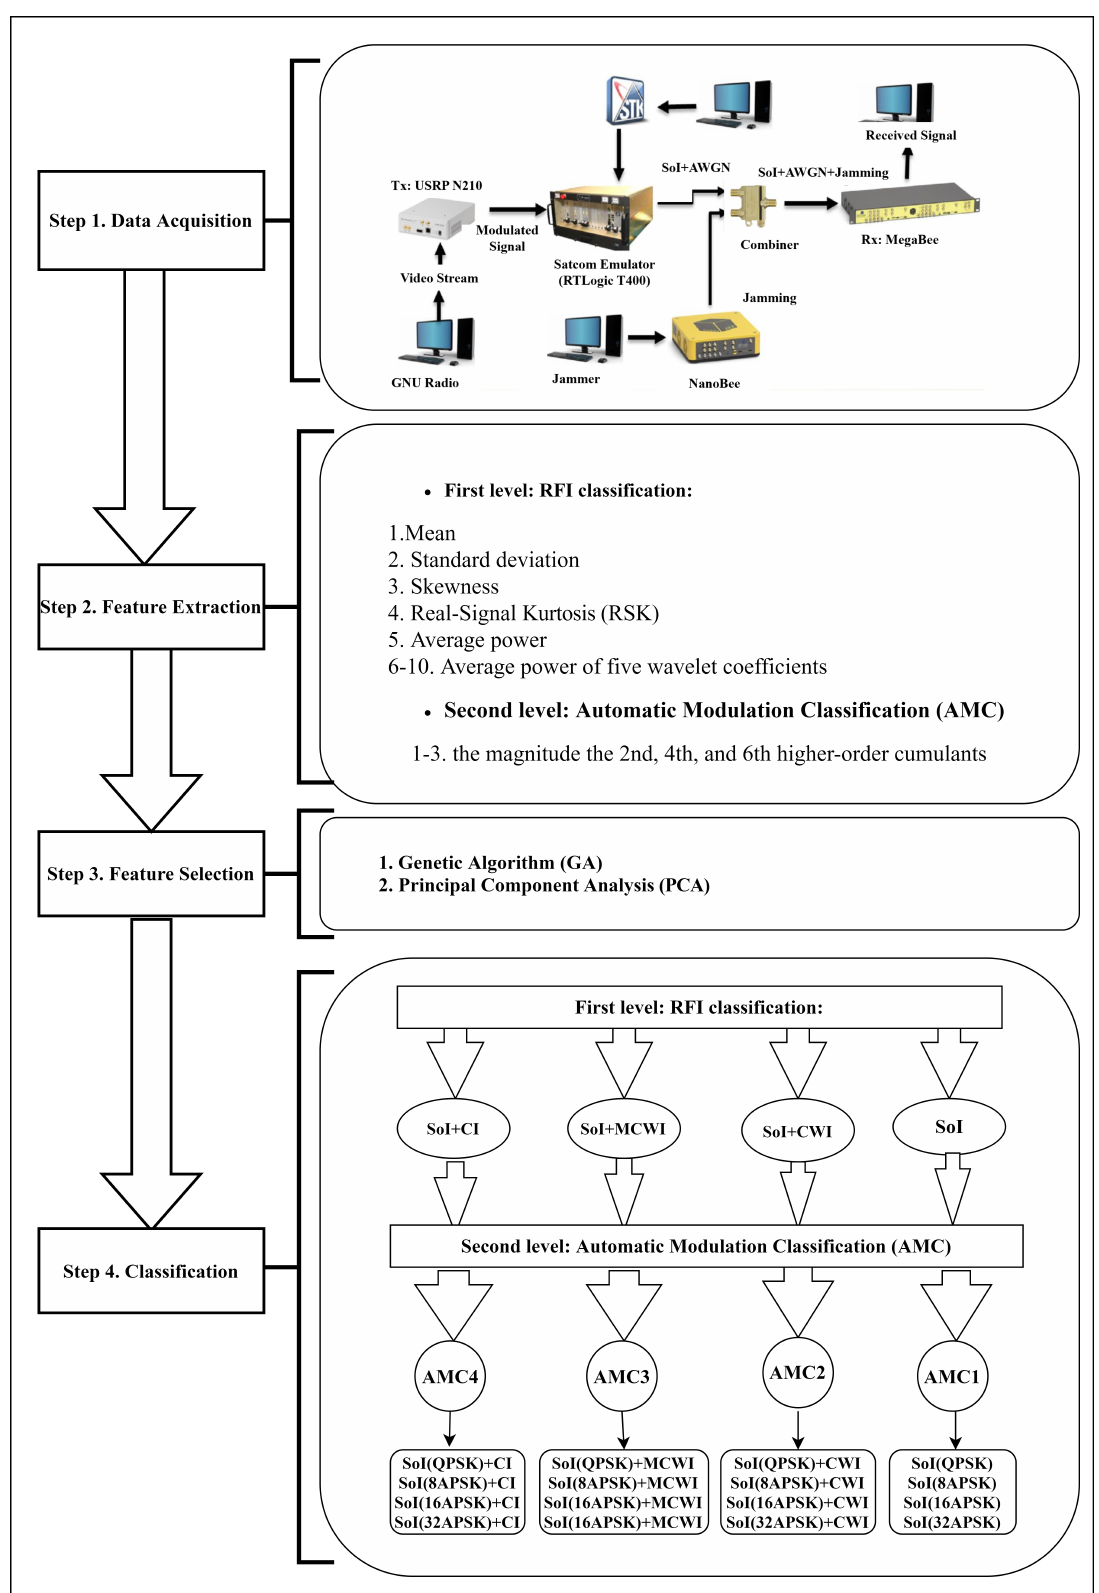
Figure 1. Proposed RFI recognition and characterization